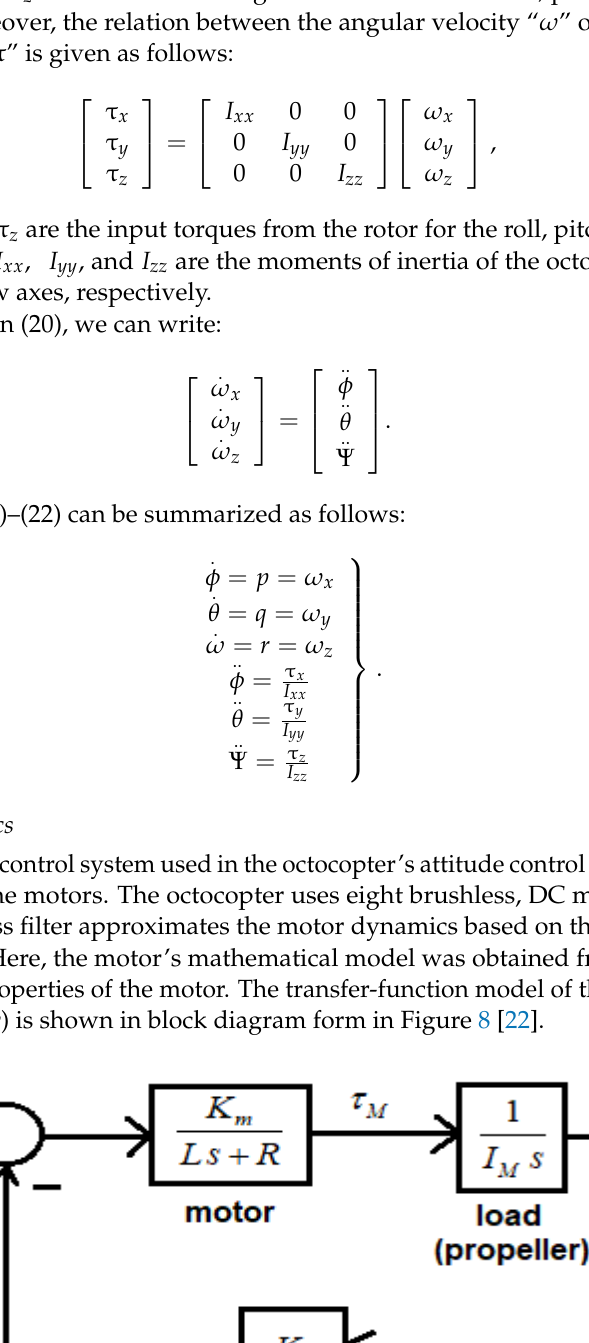
Table 1. 1000 KV Brushless DC motor specifications.